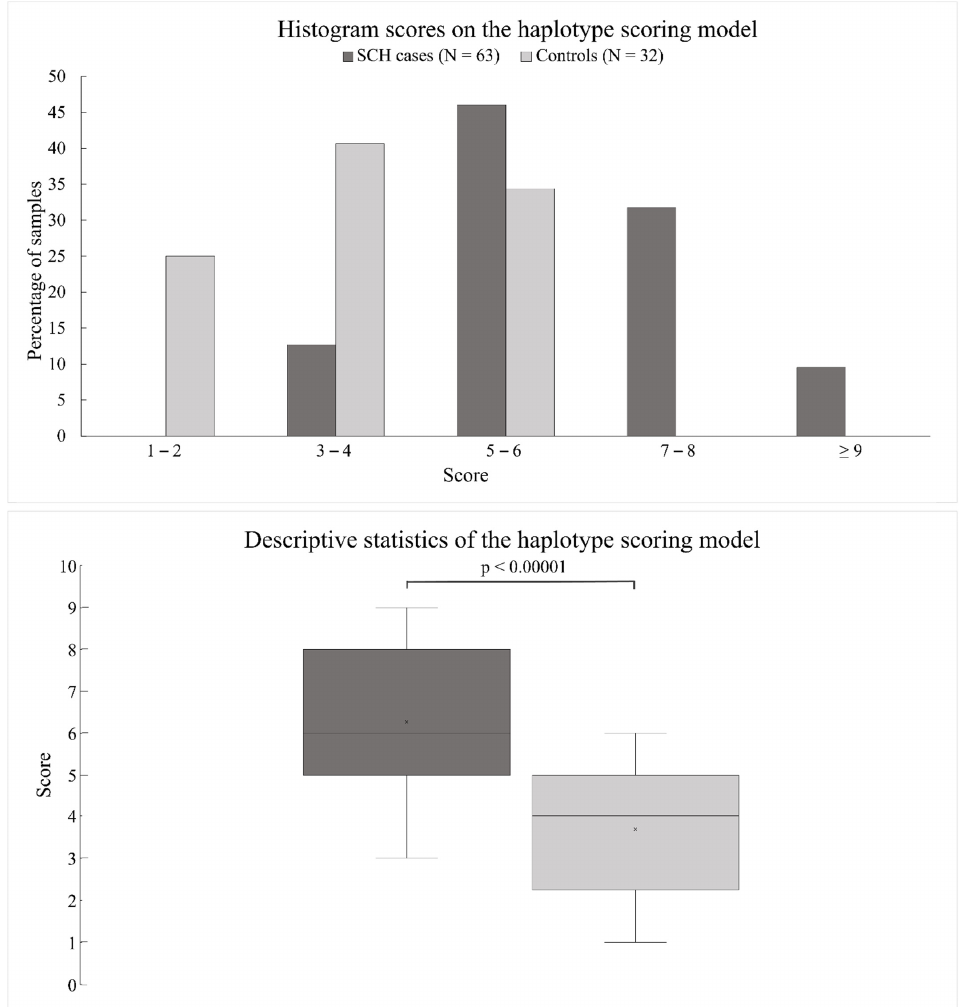
Figure 3. Score histograms and descriptive statistics of the haplotype scoring model. The top graph shows a histogram (%) of the scores distribution in both groups; SCH subjects (dark gray) and controls (light gray). In both groups, the haplotype scoring model did not deviate from the normal distribution. The bottom graph shows a boxplot of the scores in the SCH patients (dark gray) and the controls (light gray). There was a significant difference between the medians of the two groups ( p < 0.00001). The mean score was 6.27 ± 1.58 in the SCH subjects and 3.69 ± 1.40 in the controls.